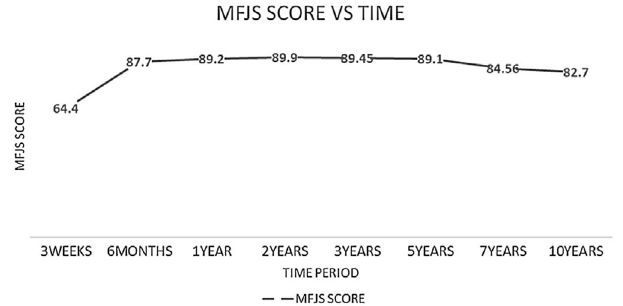
Figure 1. The trend of the MFJS score at each follow-up interval.